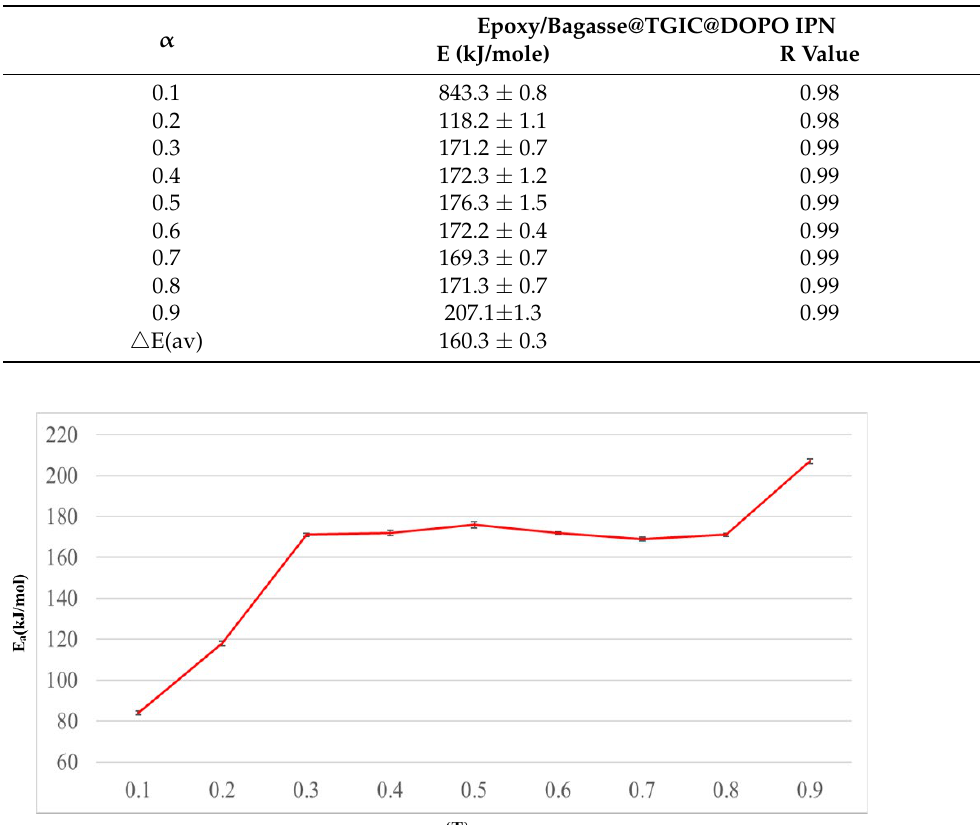
Figure 2. Activation energies (Ea) as a function of conversion for Epoxy/Bagasse @TGIC@ DOPO IPN 30% determined through Ozawa’s method. Table 1. The calculated activation energy of thermal degradation with various conversions by Ozawa’s